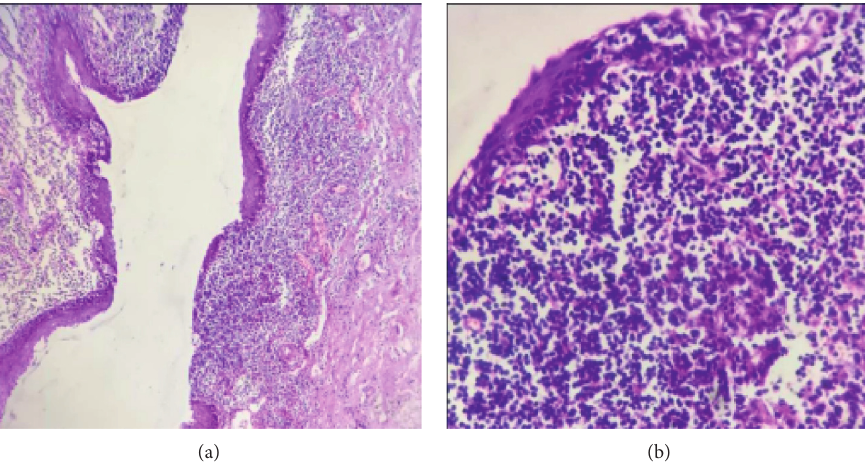
Figure 3: Histopathological examination of resected specimen. (a) Low power view of an invaginated part of the cyst, lined by attenuated stratified squamous epithelium with abundant subepithelial lymphoid tissue (H & E, × 100). (b) Close up view of a focally ulcerated area of the surface squamous epithelium encroached upon by heavy lymphocytic infiltrate including reactive lymphoid follicles (H & E, × 400).